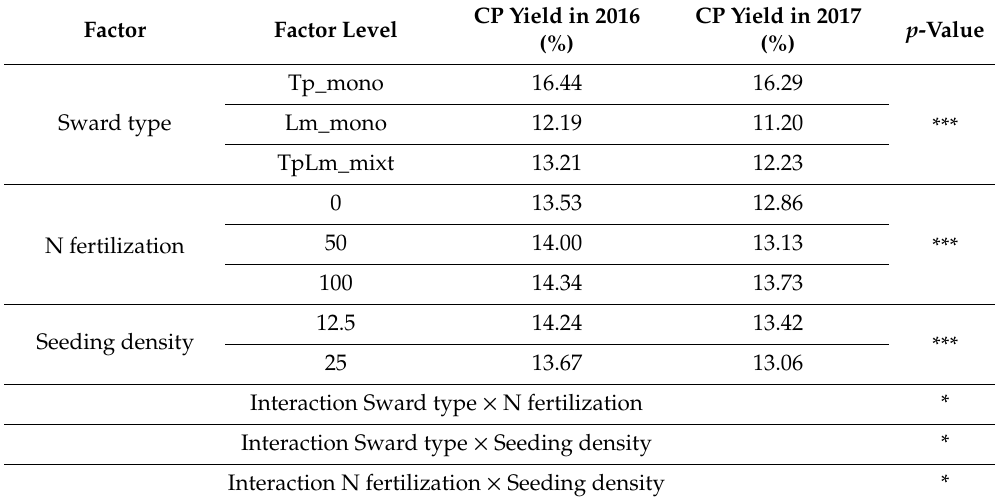
Table 4. Crude protein content in monoculture and